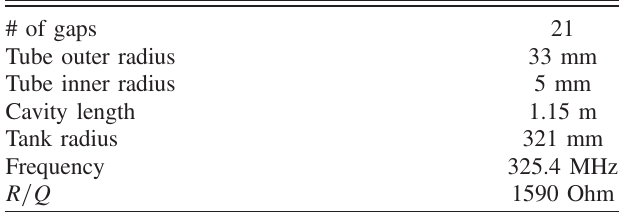
TABLE II. Parameters of the aluminium model cavity.